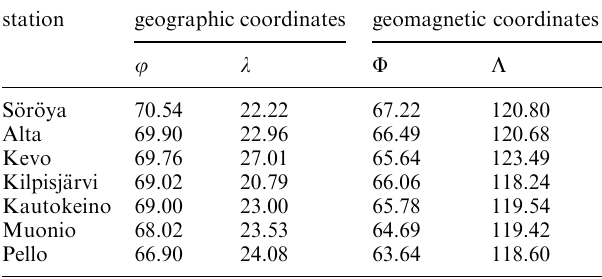
Table 2. EISCAT magnetometer cross stations station geographic coordinates